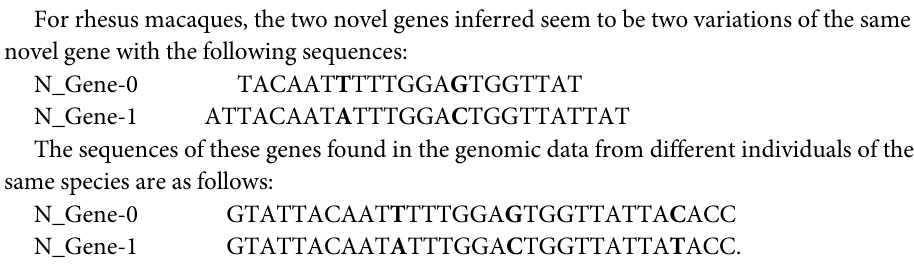
Table 3. Information about inferred D genes. The number of novel genes and variations validated using genomic data (procedure described later) are shown. Species IMGT #Individuals